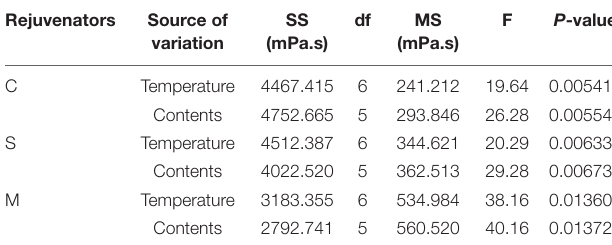
TABLE 6 | Two-factor ANOVA on the G*/sin δ of recovered bitumen ( α =